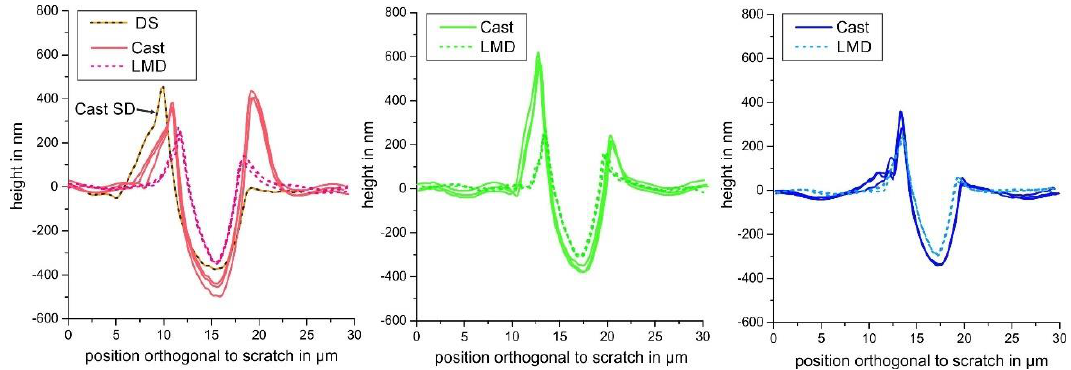
Figure 12. Height profiles orthogonal to the scratch groove in the different specimens and grain orientations.